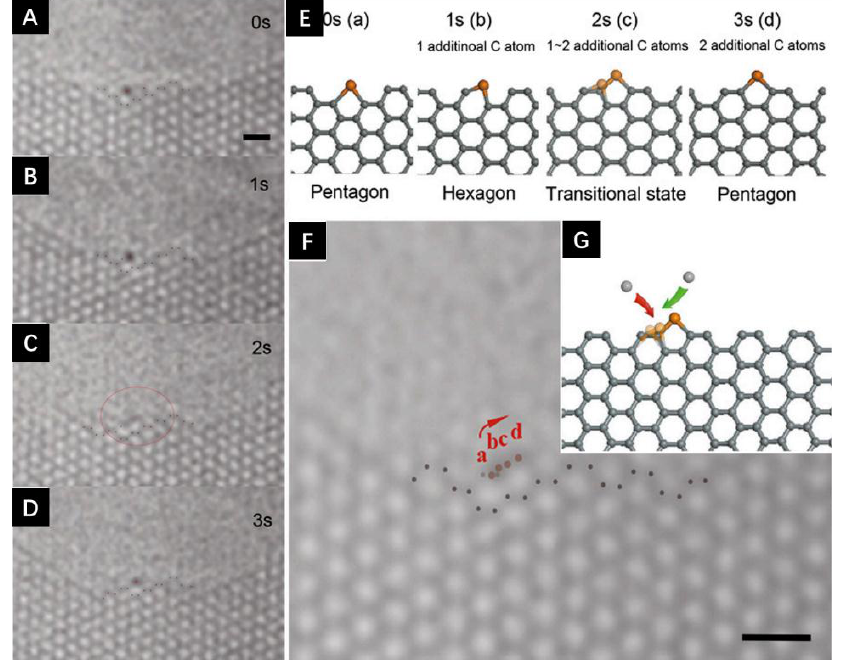
Figure 4. Catalytic growth of graphene edge by single Fe atom. ( A – D ) show the motion of the Fe atom along the pore edge. ( E ) The atomic structures for A–D. ( F ) The combination of A–D, which shows the trace of the Fe atom during the one-unit cell translocation. ( G ) The atomic structure for the whole growth process. All scale bar: 0.5 nm. Reproduced with permission. Ref. [45] Copyright (2014), National Academy of Sciences.